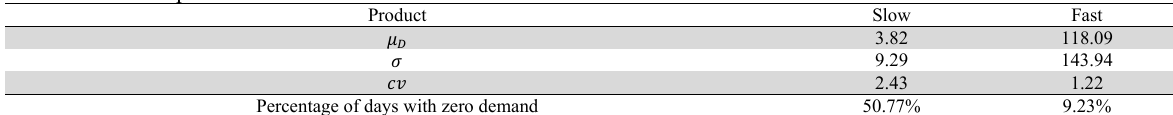
Characteristics of